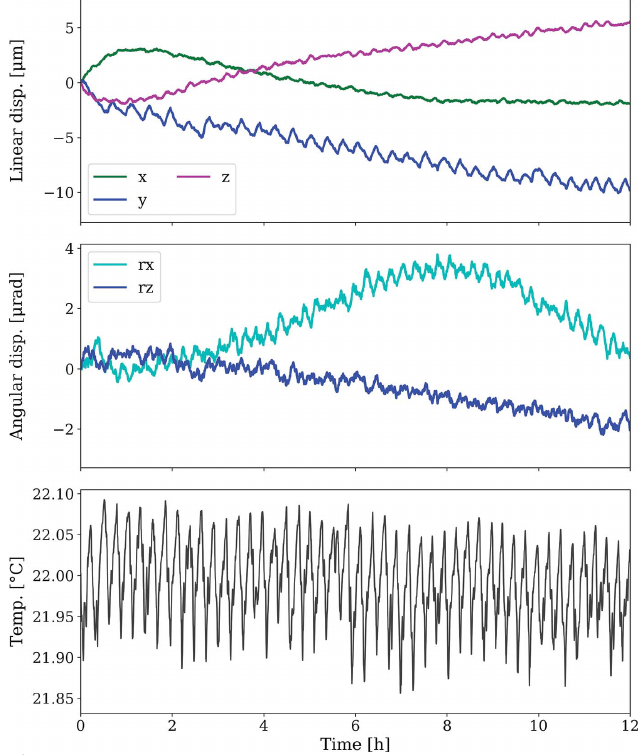
Figure 8 Linear and angular displacement, together with temperature, over a 12 h period under operational conditions for the intermediate position 2 ( (cid:2) = 90 (cid:2) , (cid:3) = 0 (cid:2) , radius at 300